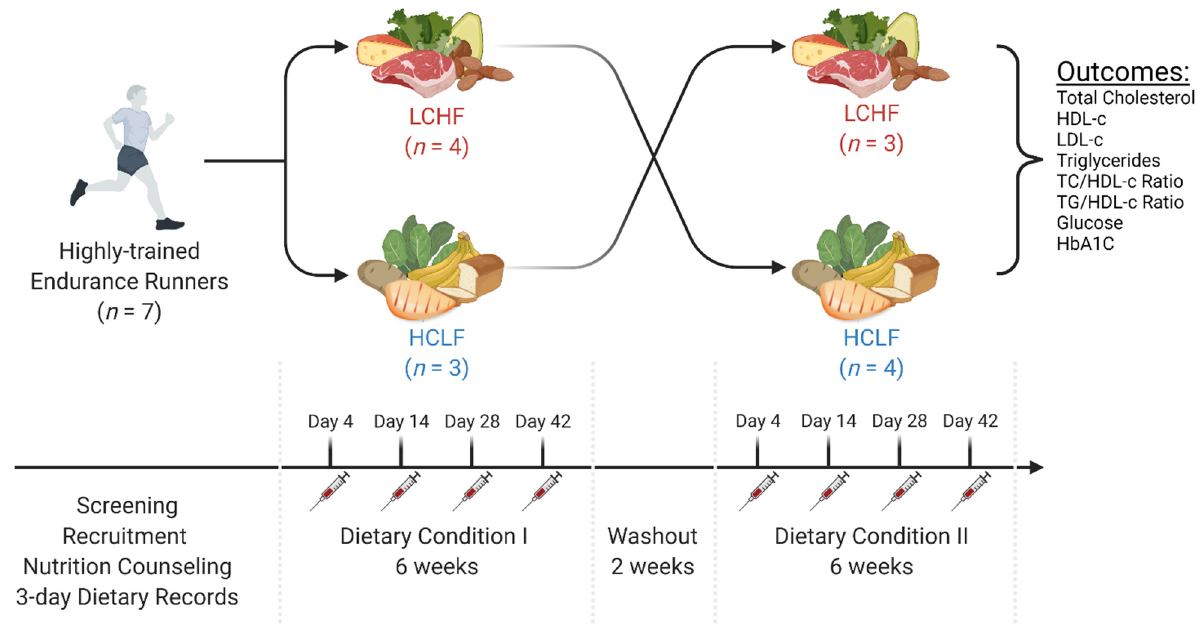
Figure 1. Experimental Approach. In a randomized, counterbalanced, cross-over manner, seven recreationally trained endurance athletes were assigned to consume either a low-carbohydrate/high- fat diet (LCHF) or high-carbohydrate/low-fat diet (HCLF) for six weeks. A two-week washout was allowed between each dietary phase. All participants maintained a constant exercise regimen and a 3-day food log throughout the experimental phases. Repeat intravenous and capillary blood measures were collected on days 4, 14, 28, and 42 during each feeding condition. The exploratory goal of this study was to assess the main effects and interactions of LCHF and HCLF on comprehensive blood lipid and glucose panel markers. This figure was created with BioRender ® .